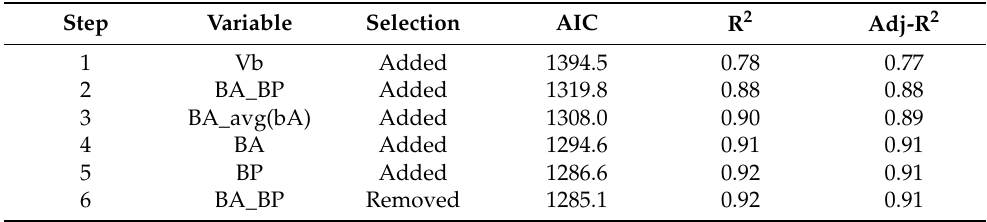
Table 4. Variable selection summary of the forward stepwise regression analysis, on the training set; between bunch weight (predictor) and bunch area (BA); bunch perimeter (BP); visible berry number (Vb); average berry area (bA); and the ratios between BA and BP (BA_BP), BA and Vb (BA_Vb), and BA and average berry area (BA_avg(bA)).